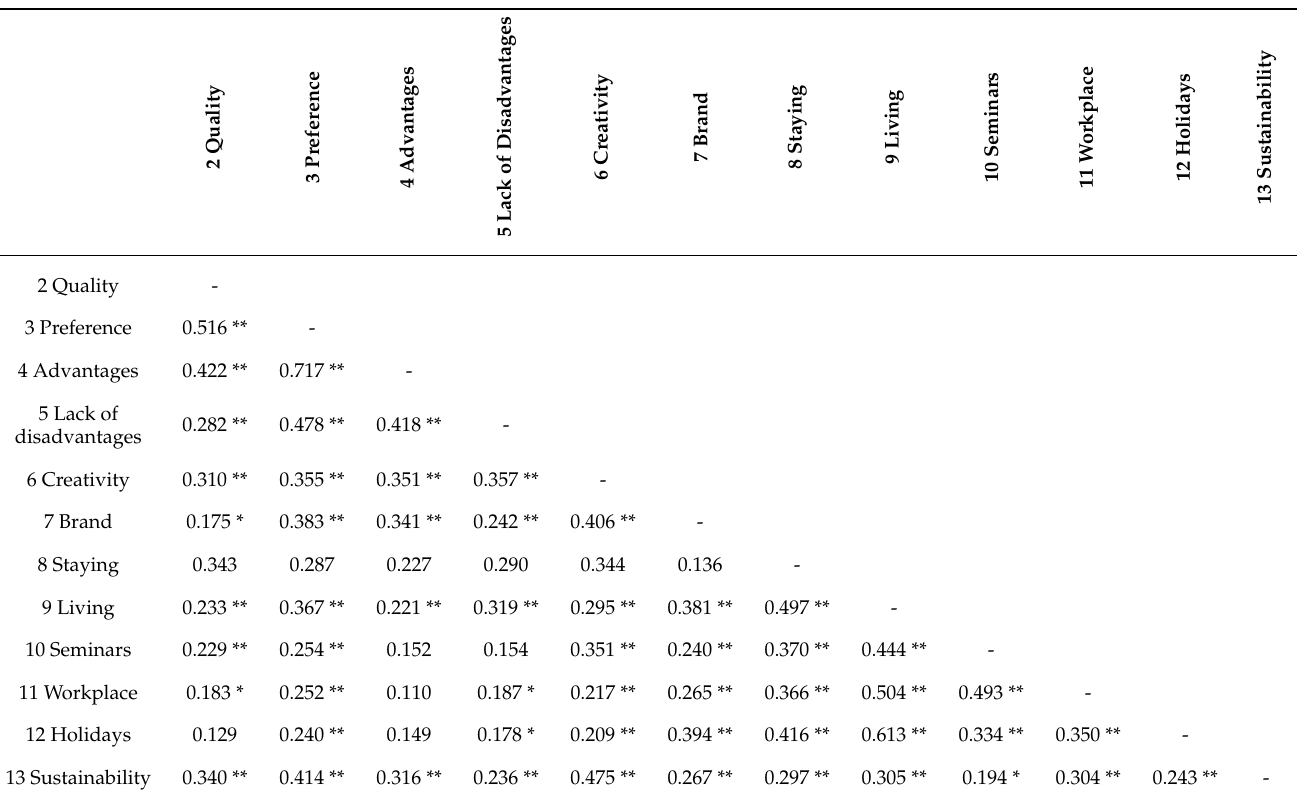
Table 5. Correlations among evaluation